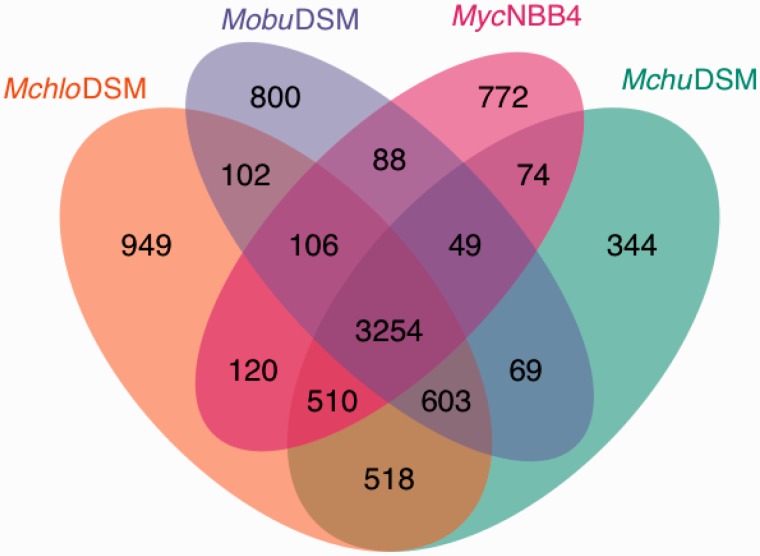
Venn diagram—presence of homologous and nonhomologous genes. The Venn diagram represents homologous and nonhomologous genes present in MchloDSM, MchuDSM, MobuDSM, and MycNBB4. The Venn diagram was generated as outlined in Materials and Methods and the different mycobacterial strains are color coded as indicated.